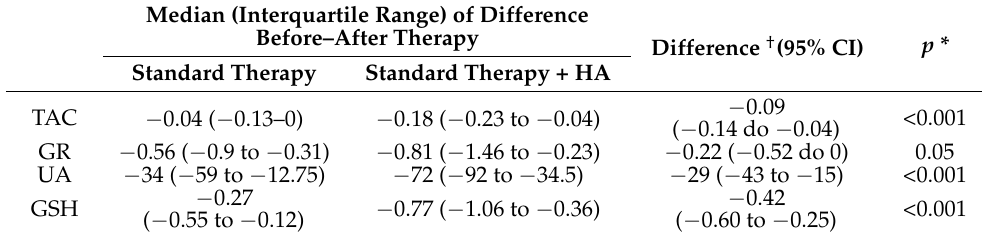
Table 3. Absolute differences in measured parameters before and after therapy in both groups. Median (Interquartile Range) of Difference Before–After